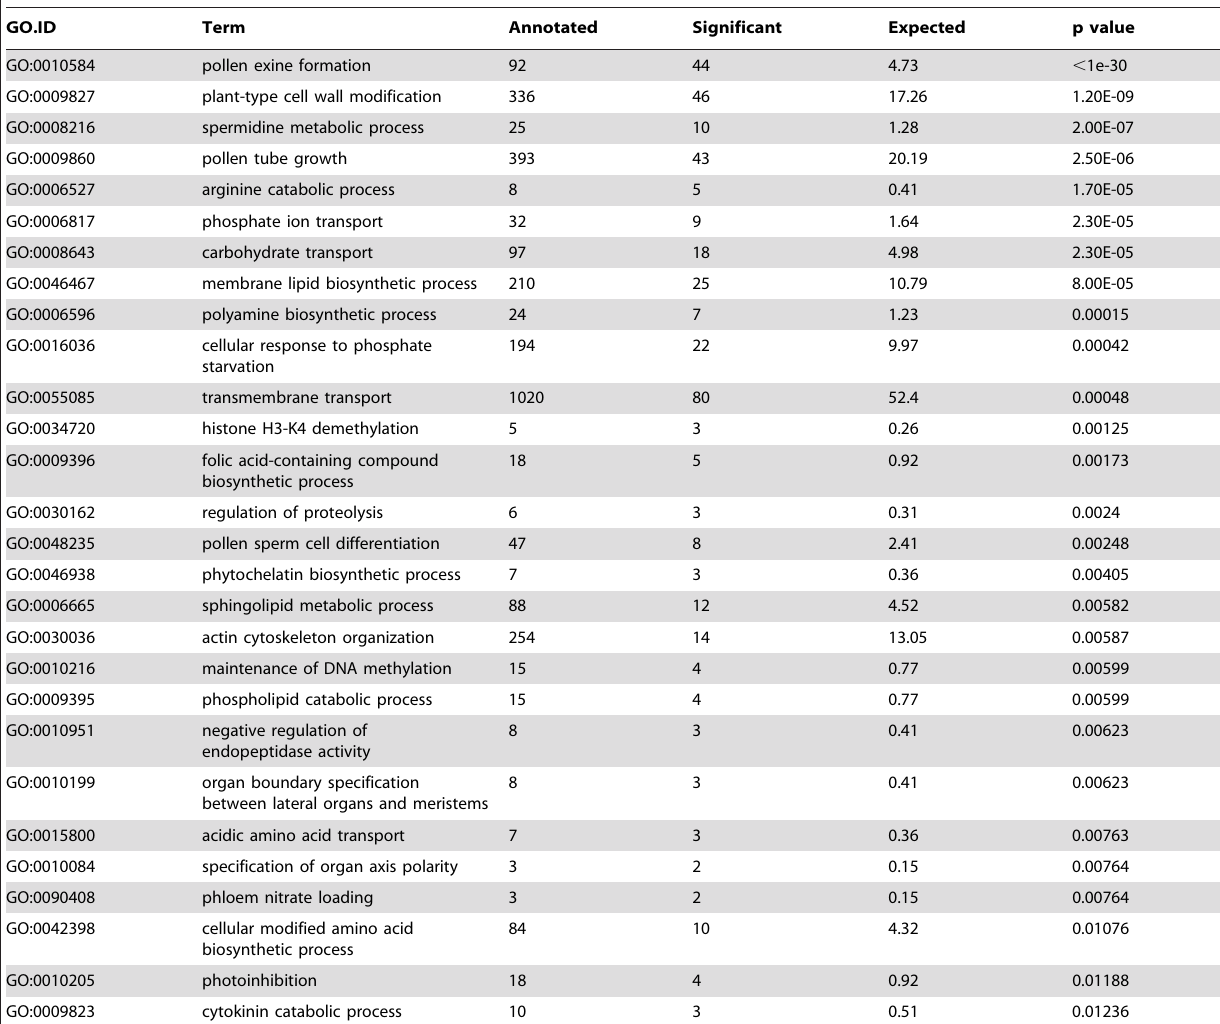
Table 2. Gene ontology